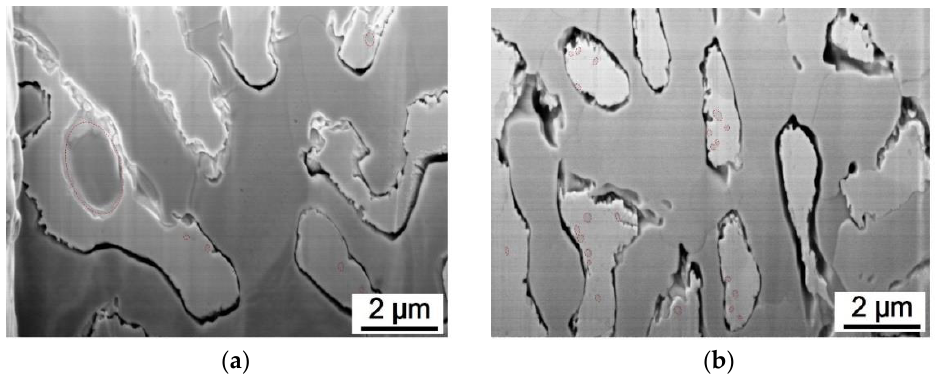
Figure 6. Microstructures ( a ) of the as-cast Bi – Sn sample and ( b ) after t-HPS processing for five turns and storage at RT for 8 h.